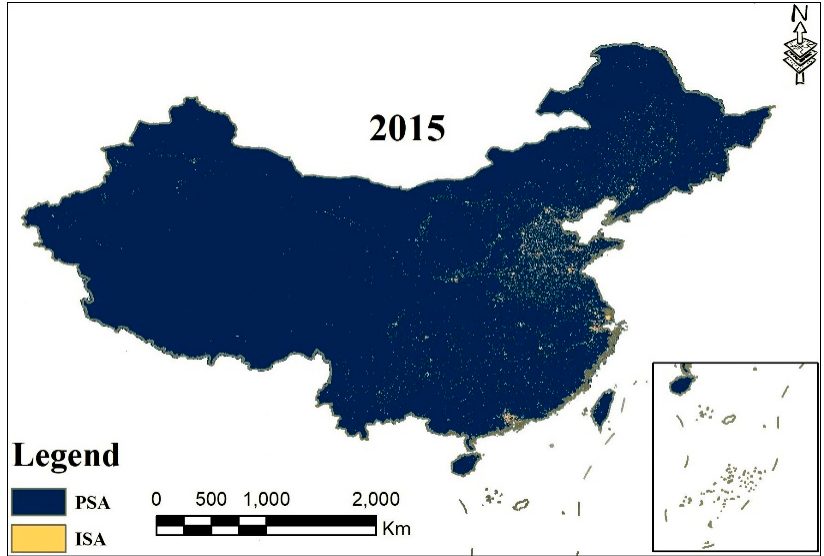
Figure 11. The urban land distribution in China for the year 2015. The blue area represents the pervious surface area (PSA), and the yellow represents the impervious surface area (ISA).